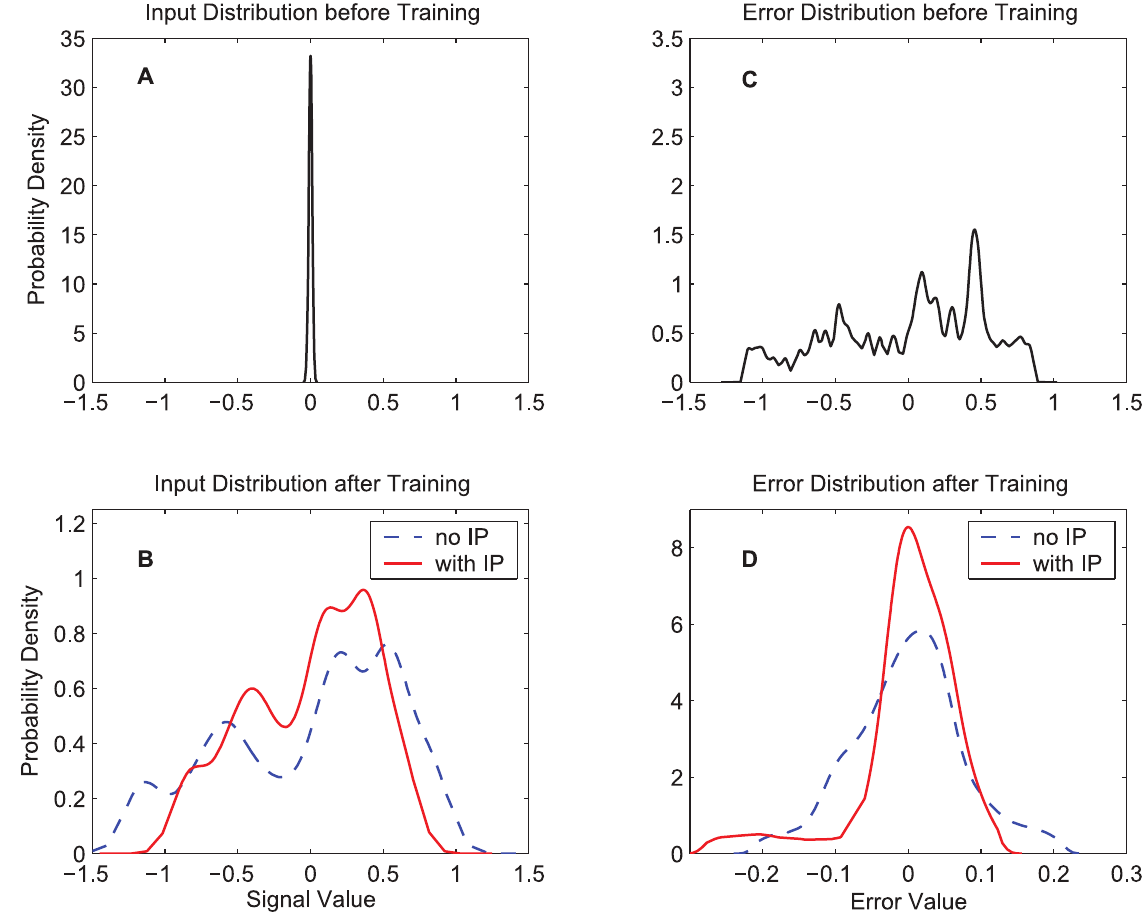
Figure 7. Input distributions for the output neuron and error distributions of the FNN. Input distributions for the single output neuron and error distributions with the training data set ‘‘MG’’ are presented. (A) Initial input distribution. (B) Input distributions after 1000-epoch training for the two algorithms. (C) Initial error distribution. (D) Error distributions after 1000-epoch training for the two algorithms. In (B) and (D), the dash lines denote the distributions obtained by the MEE algorithm, and the solid lines denote the distributions obtained by the synergistic algorithm.